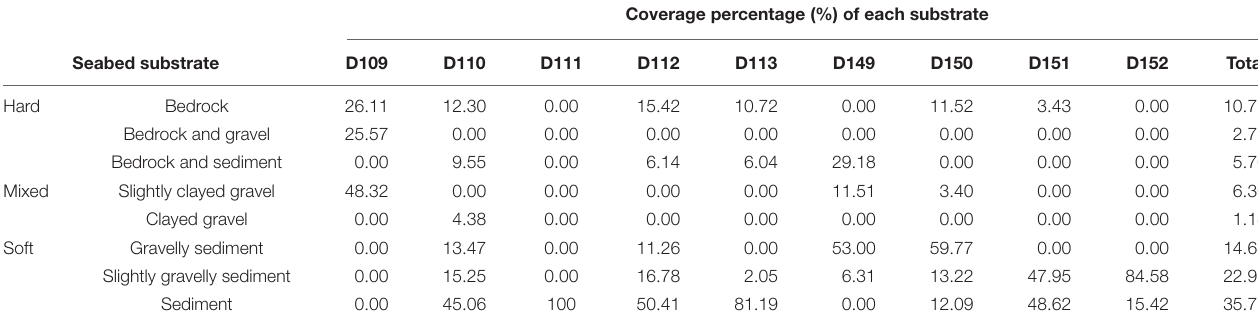
TABLE 2 | Seabed substrate classification and coverage percentage of the nine dives in the Yap Trench.